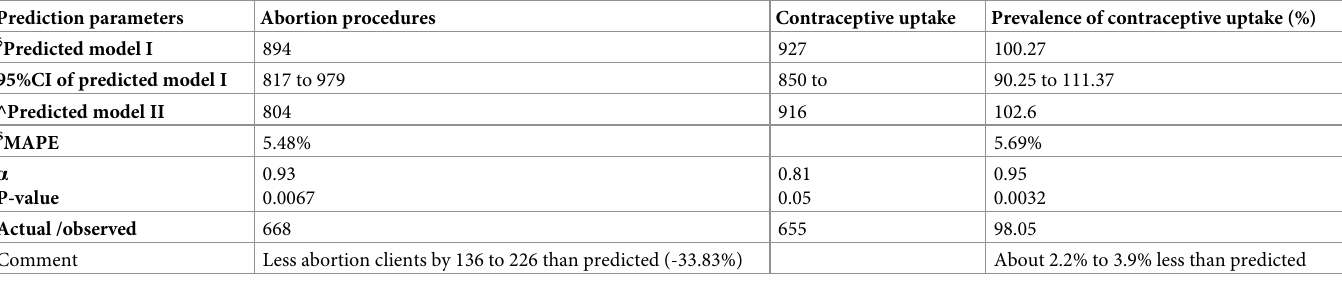
Table 7. Predicted and actual cases of abortion and contraceptive uptake during the COVID-19 era (2020). Prediction